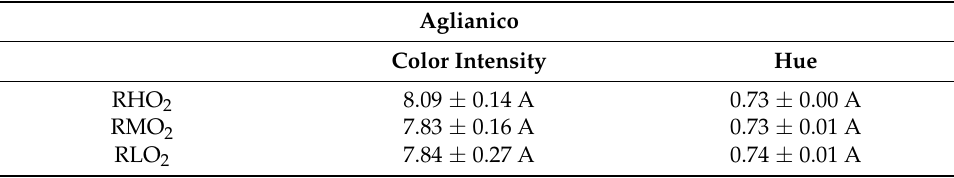
Table 5. Chromatic